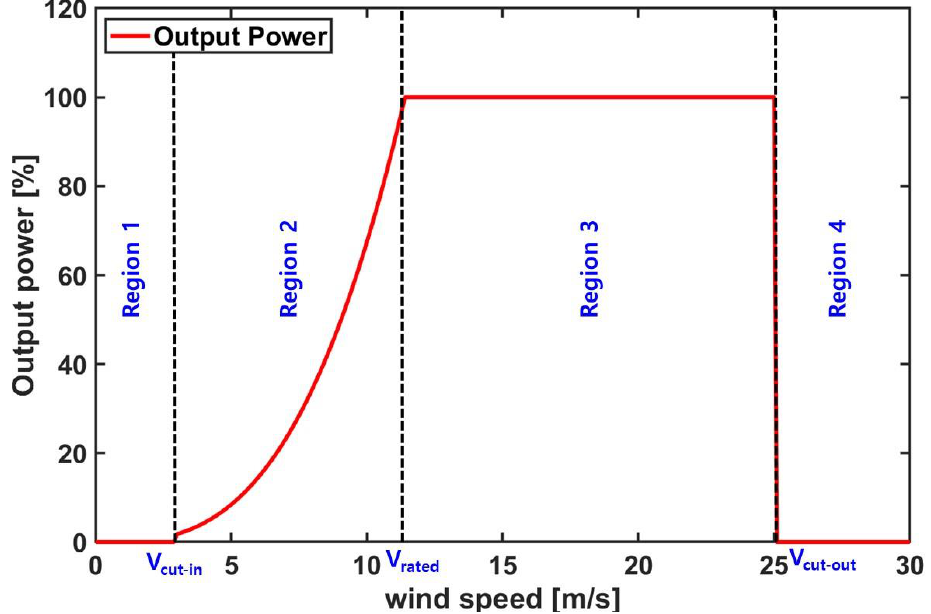
Figure 1. Wind turbine output characteristic curve according to wind speed.